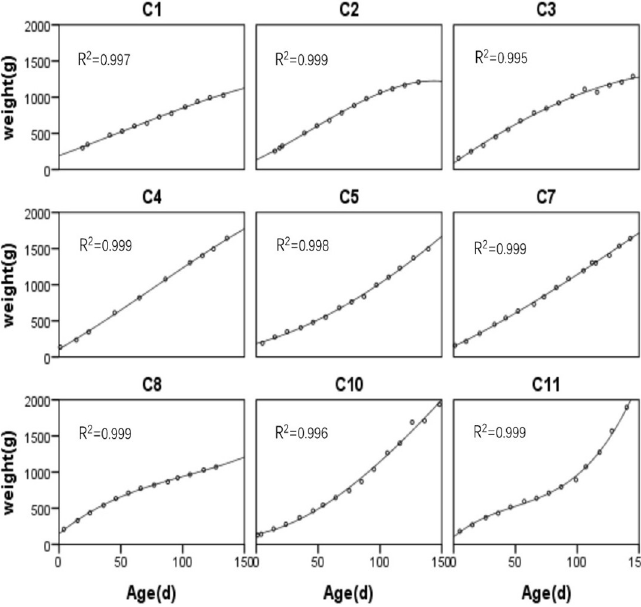
Fig 4. Fitted body mass growth curves for each of the nine Sunda pangolin ( Manis javanica ) cubs.